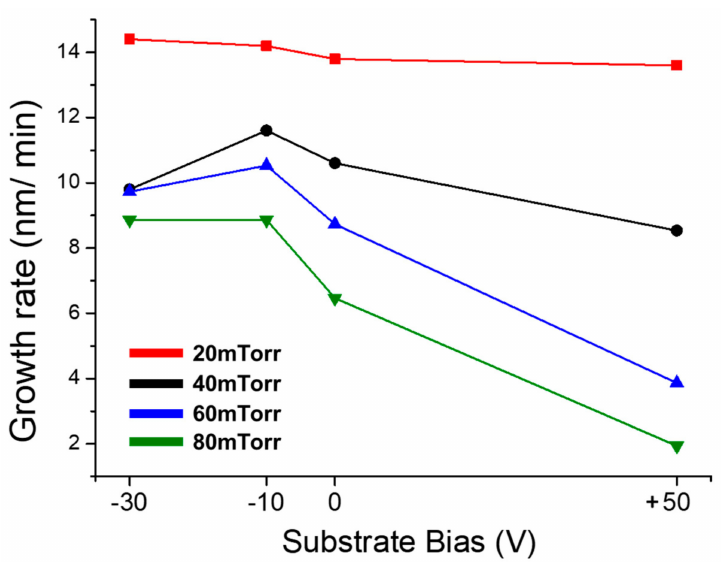
Figure 5. Growth rate of the Ti films deposited at the substrate bias of − 30, − 10, 0, and +50 V under 20, 40, 60, and 80